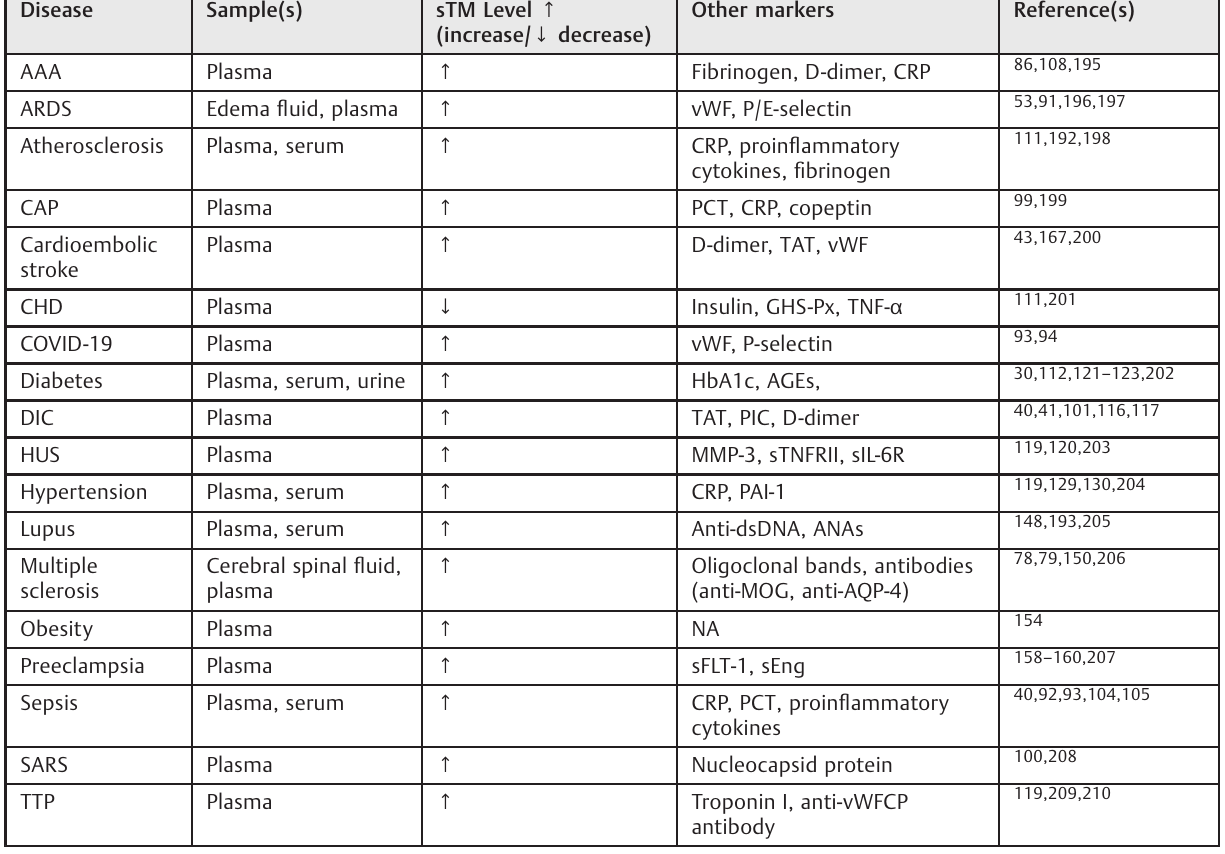
Table 3 sTM and other markers in major diseases